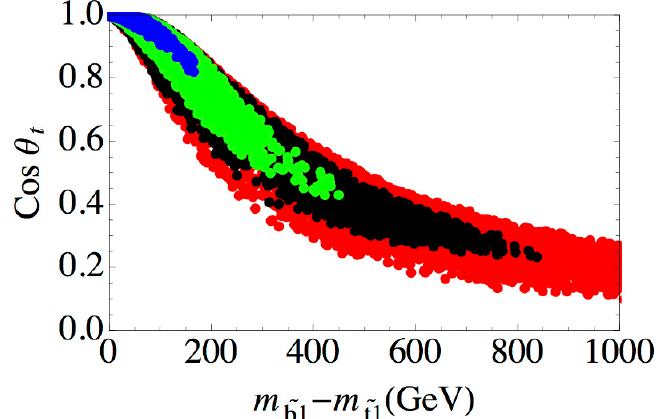
Figure 6 . Cosine of stop mixing angle as a function of the mass splitting m ~ 120 < m h < 130 GeV and m ~